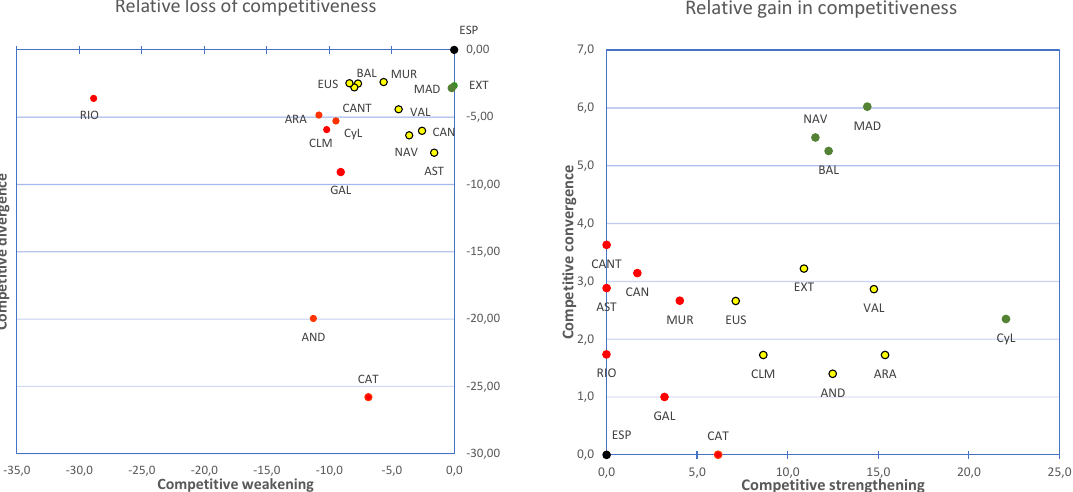
Figure 1. Strengthening points and convergences versus weakening points and divergences of Spanish regions between 2010 and 2018. Source: own work.